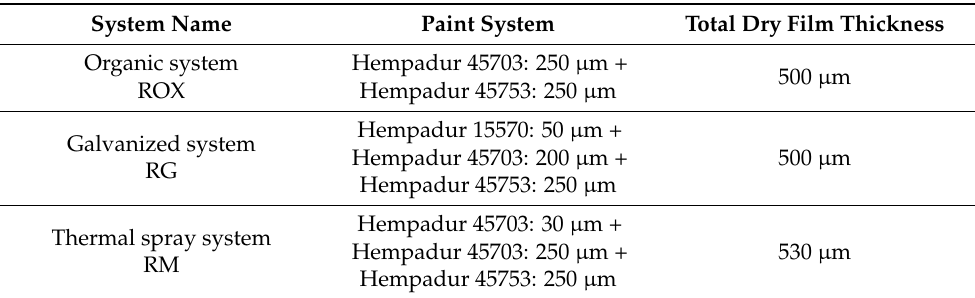
Table 1. Name of the systems, composition of the systems, and total dry film thicknesses of the studied organic coating systems.